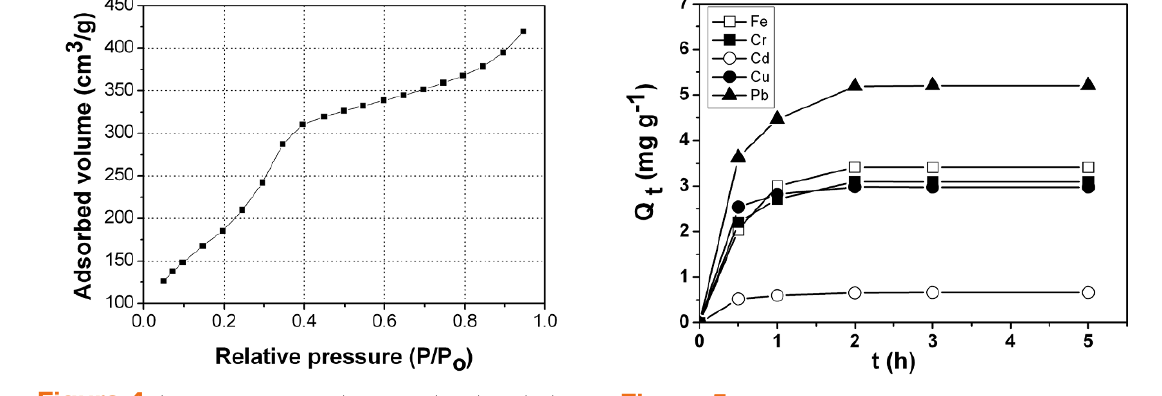
Figure 5. Effect of contact time on the amount of adsorbed Fe(III) - □ , Cu(II) - ● , Cr(III) - ■ , Cd(II) - ○ and Pb(II) - ▲ ions (C 10 mg L -1 at pH 5.0) on o